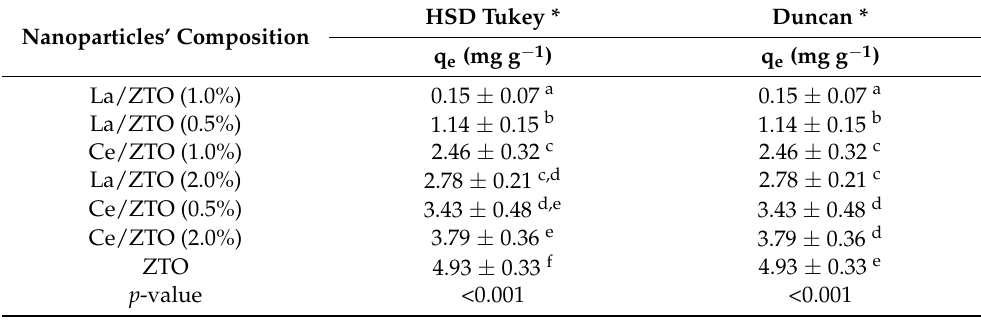
Table 1. Effect of nanoparticles’ compositions on their cyanide adsorption capacity.